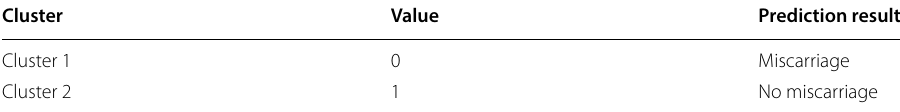
Table 7 Description of clusters